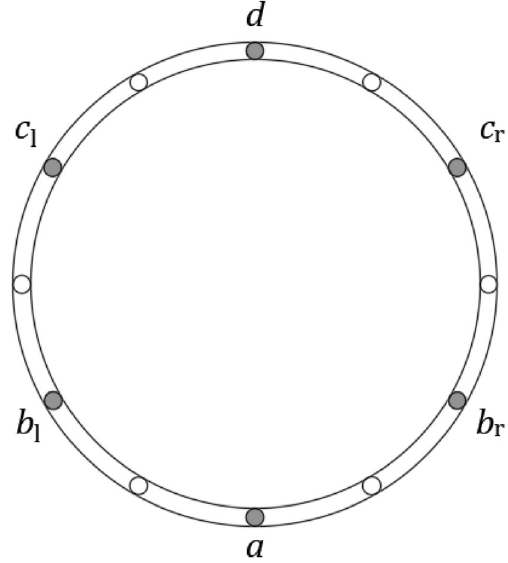
Fig. 16 The measurement points in a tunnel